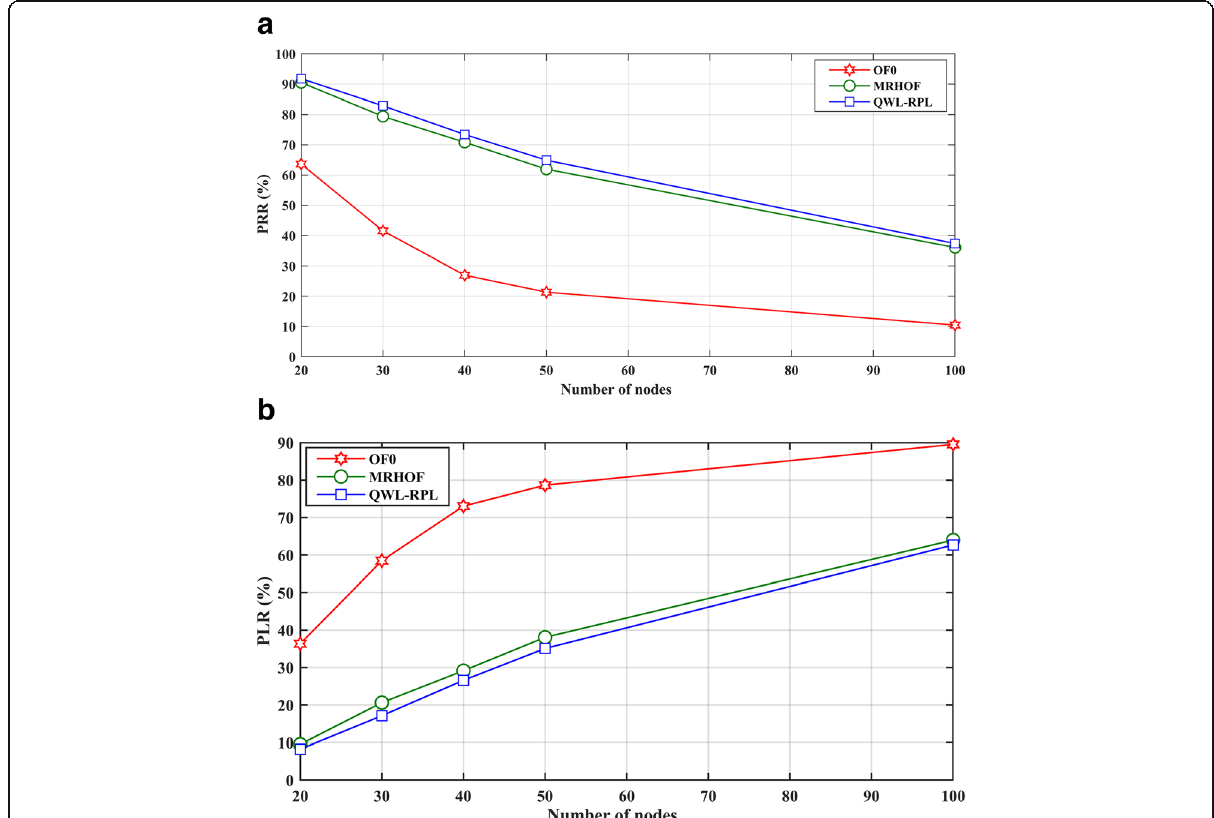
Fig. 8 Simulation analysis for the scenario II for the a packet reception ratio (%) and b packet loss ratio (%) versus number of nodes